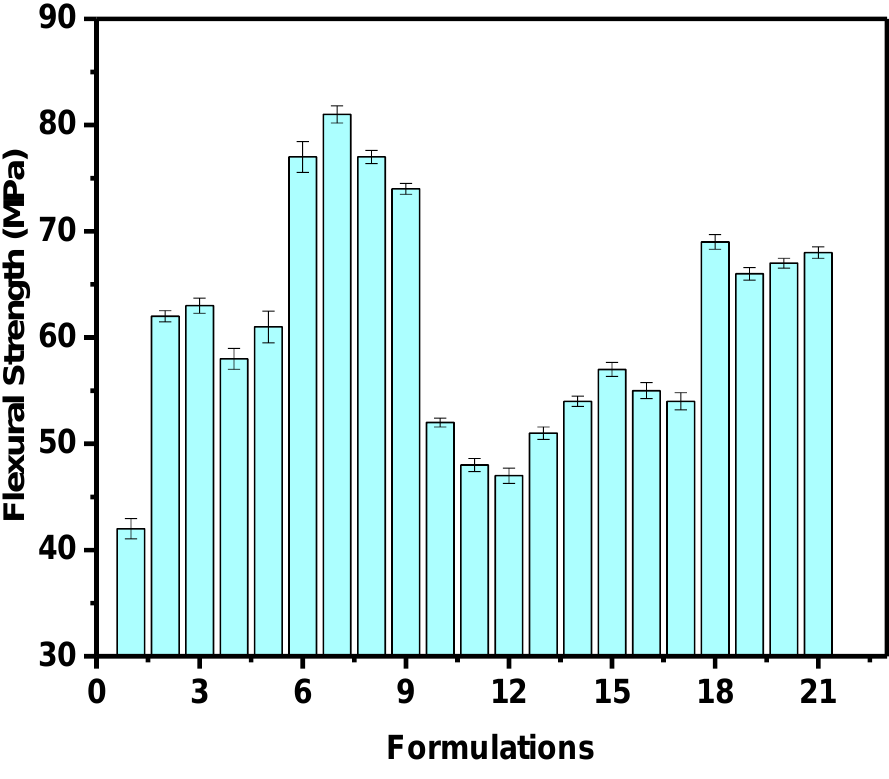
Figure 6. Flexural strength of the HDPE/filler composites.